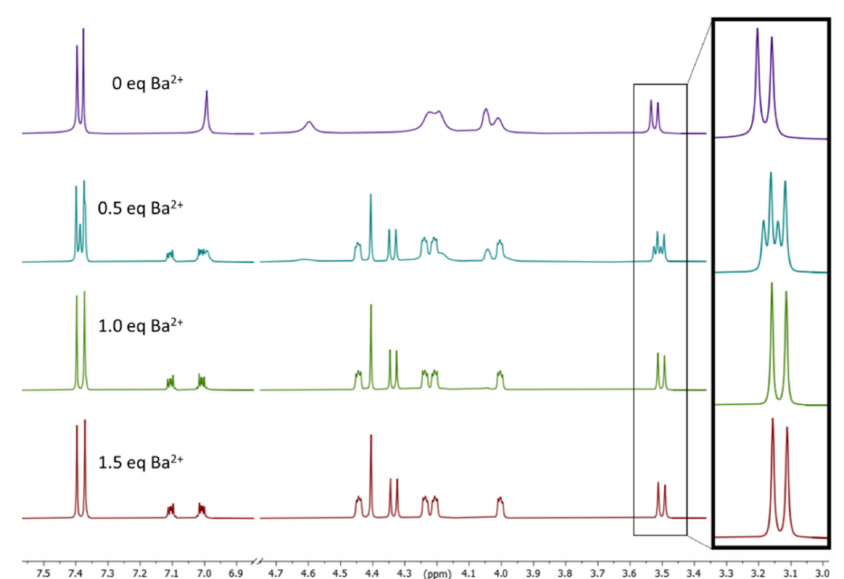
Figure 3. 1 H NMR spectra showing the change in chemical shifts by treatment of calix 24 with different equivalents of Ba(ClO 4 ) 2 in acetonitrile-d 3